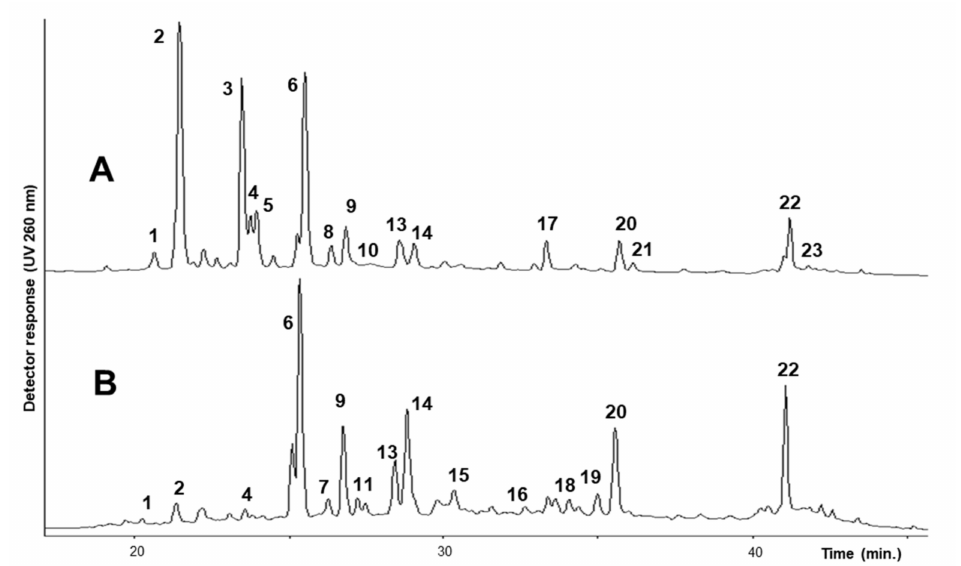
Figure 1. HPLC/DAD (UV 260 nm) chromatogram of flavonoids from ( A ) flowers and ( B ) leaves of H. coronarium L. For compounds numbering and identification, see Table